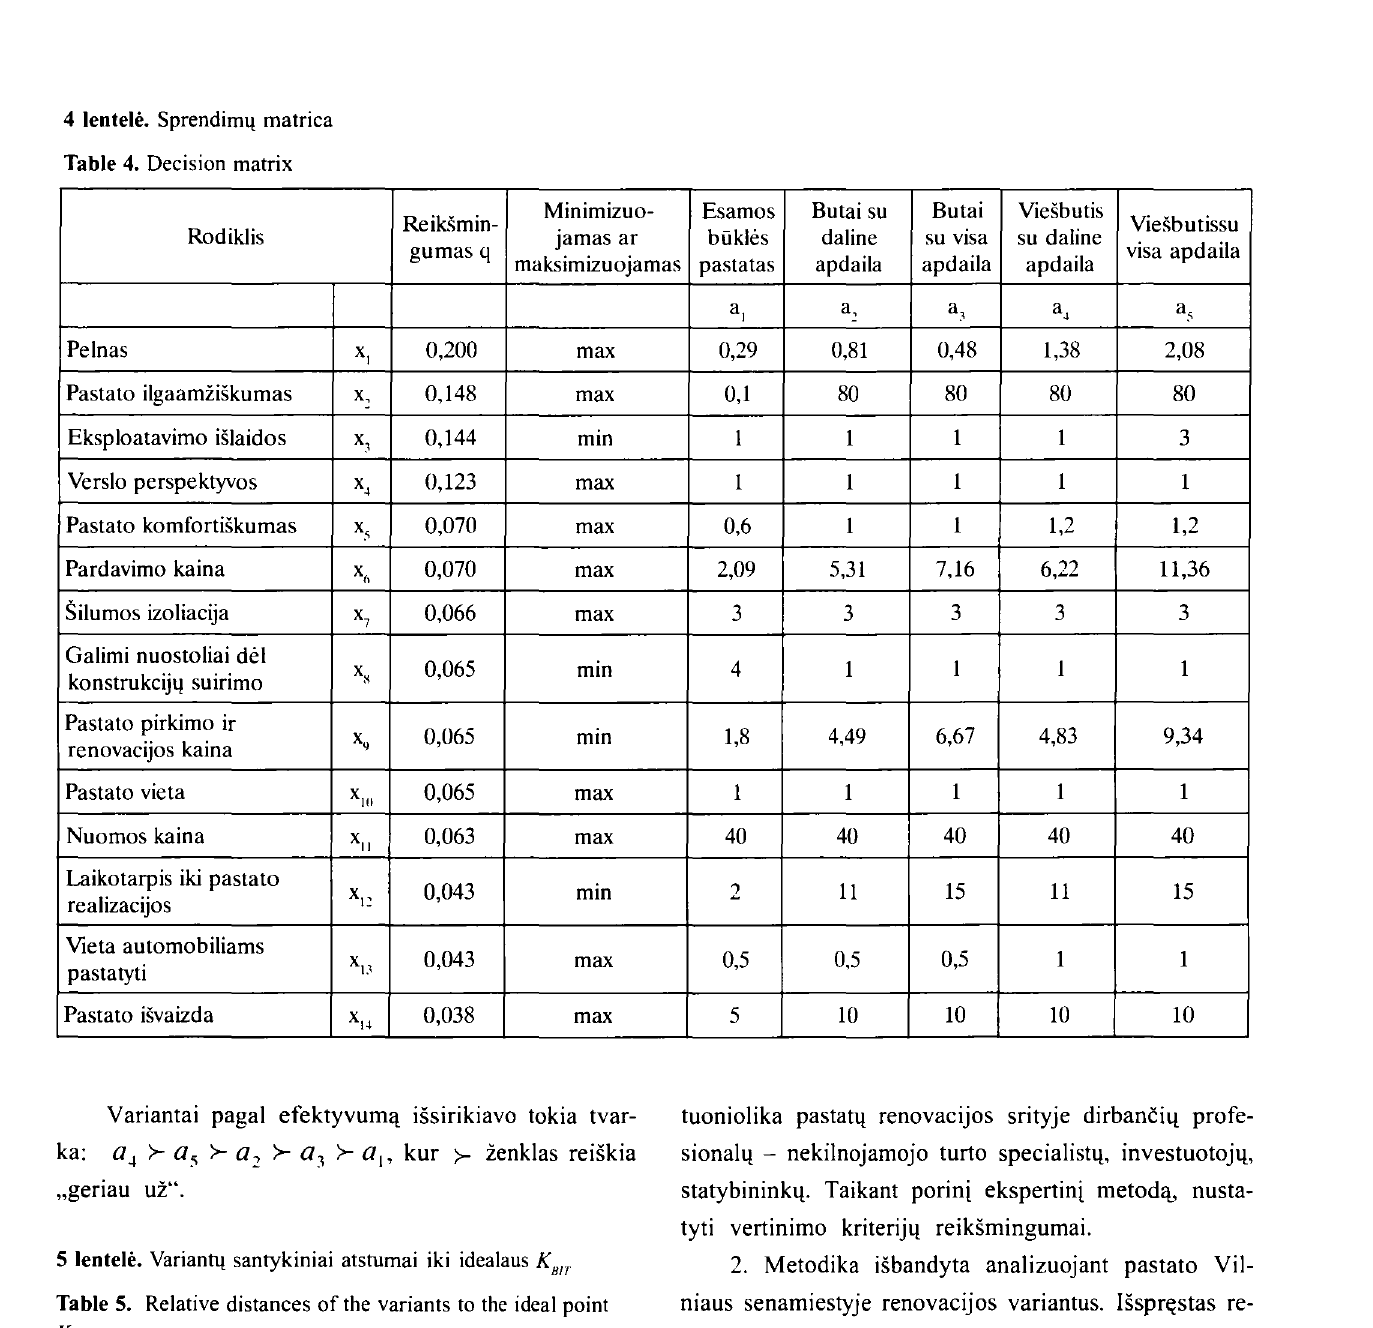
Table 5. Relative distances of the variants to the ideal